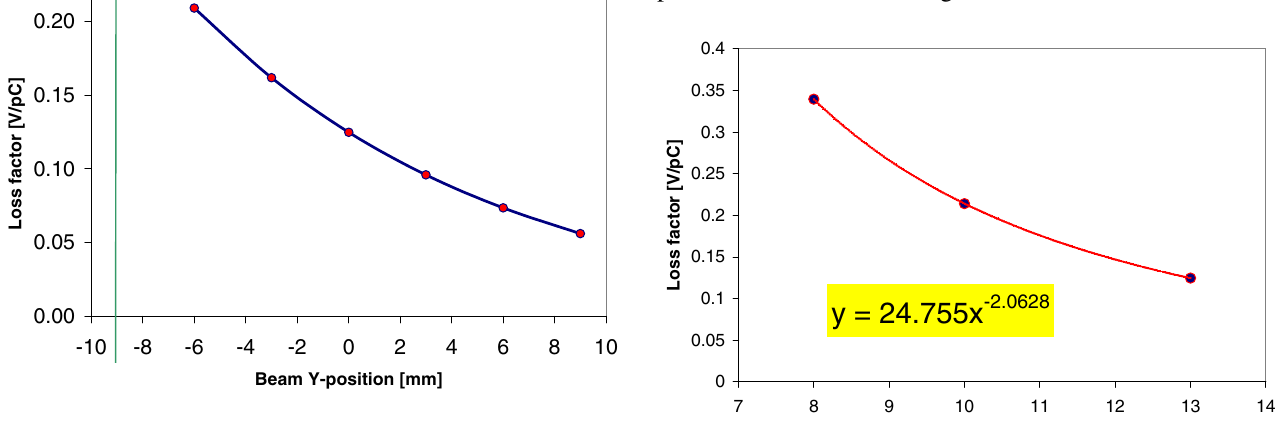
FIG. 2. (Color) Loss factor of a 13 mm long Gaussian bunch passing the vertical collimator at different offsets in the vertical position. The green line shows the collimator edge. FIG. 4. (Color) Loss factor as a function of bunch length.